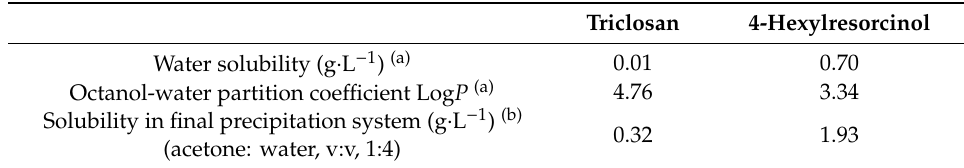
Table 1. Substance data of biocides Triclosan and 4-Hexylresorcinol. Manufactory data (a) and determined via solubility measurements (b) .